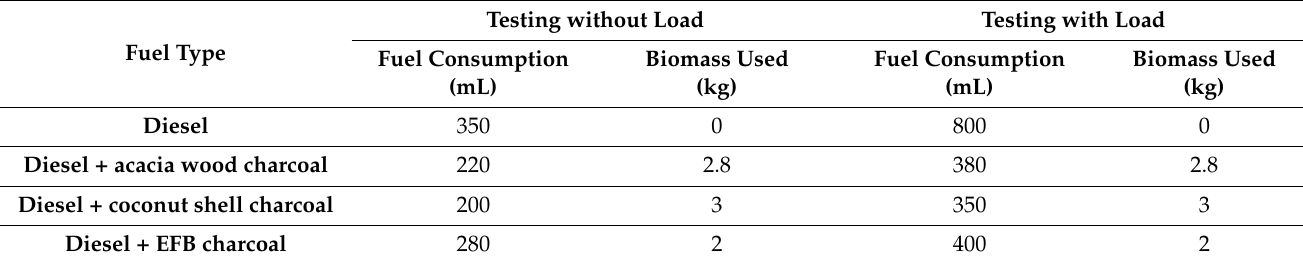
Table 1. Comparison of various biomass waste fuel efficiency.